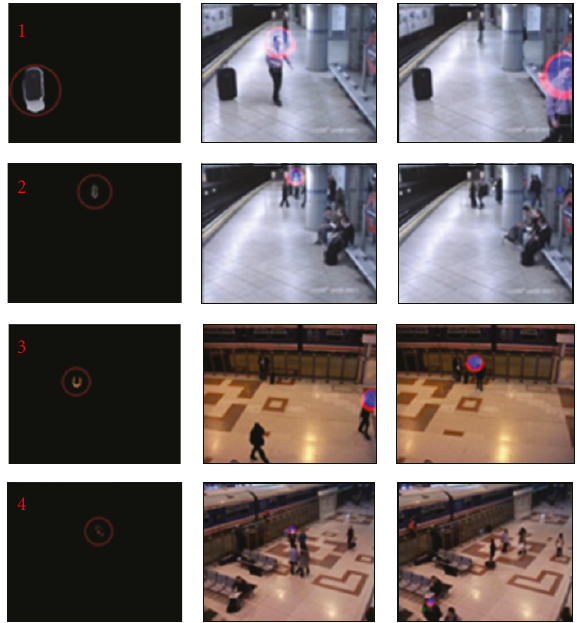
Figure 8: Sequence 1, 3, and 4: (from left) static luggage detected; owner tracking starts; owner leaves the scene, alarm triggered. Sequence 2: static luggage detected; owner tracking starts; owner lost due to occlusion, alarm triggered. Sequence 1 and 2 are from AVSS 2007 dataset. Sequence 3 and 4 are from PETS 2006